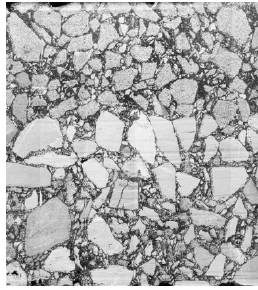
Figure 8. Grayscale image.